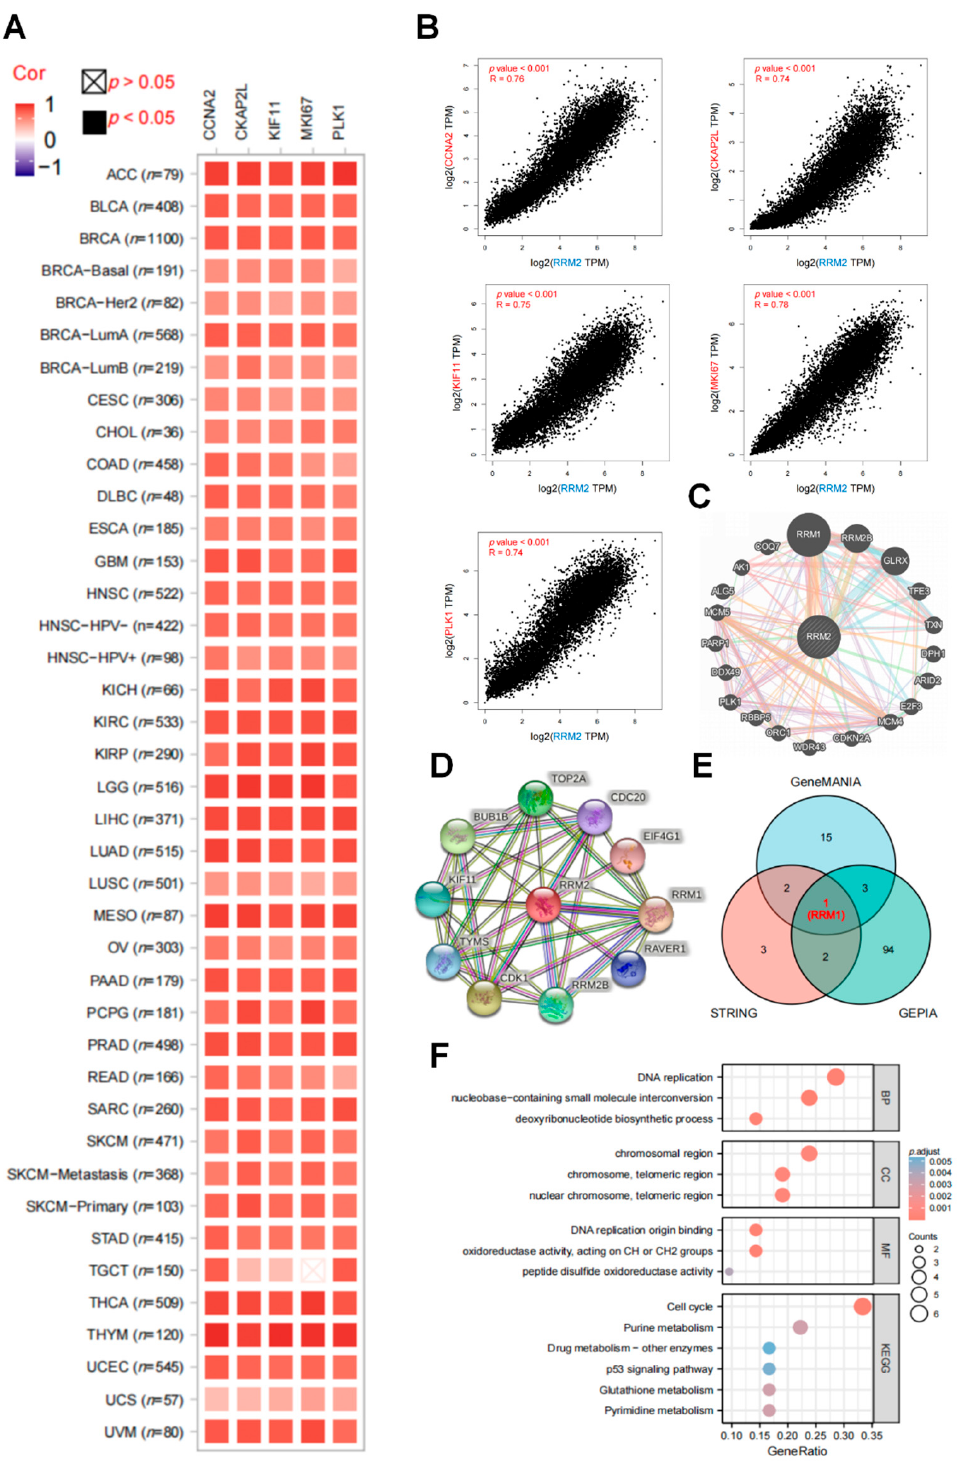
Figure 5. Enrichment analysis of RRM2-related partners. ( A ) The heatmap showed that RRM2 was positively related to the 5 selected genes in TCGA cancers via TIMER2.0. ( B ) The expression correlation between RRM2 and 5 selected genes (CCNA2, CKAP2L, KIF11, MKI67 and PLK1) ( C , D ) PPI network for RRM2 in GeneMANIA (http://www.genemania.org/, accessed on 26 February 2022) ( C ) and STRING (https://string-db.org/, accessed on 26 February 2022) ( D ). ( E ) Venn diagram of RRM2-interacted and correlated genes (RRM1). ( F ) KEGG and GO analyses of RRM2 to determine the functions and pathways of RRM2.